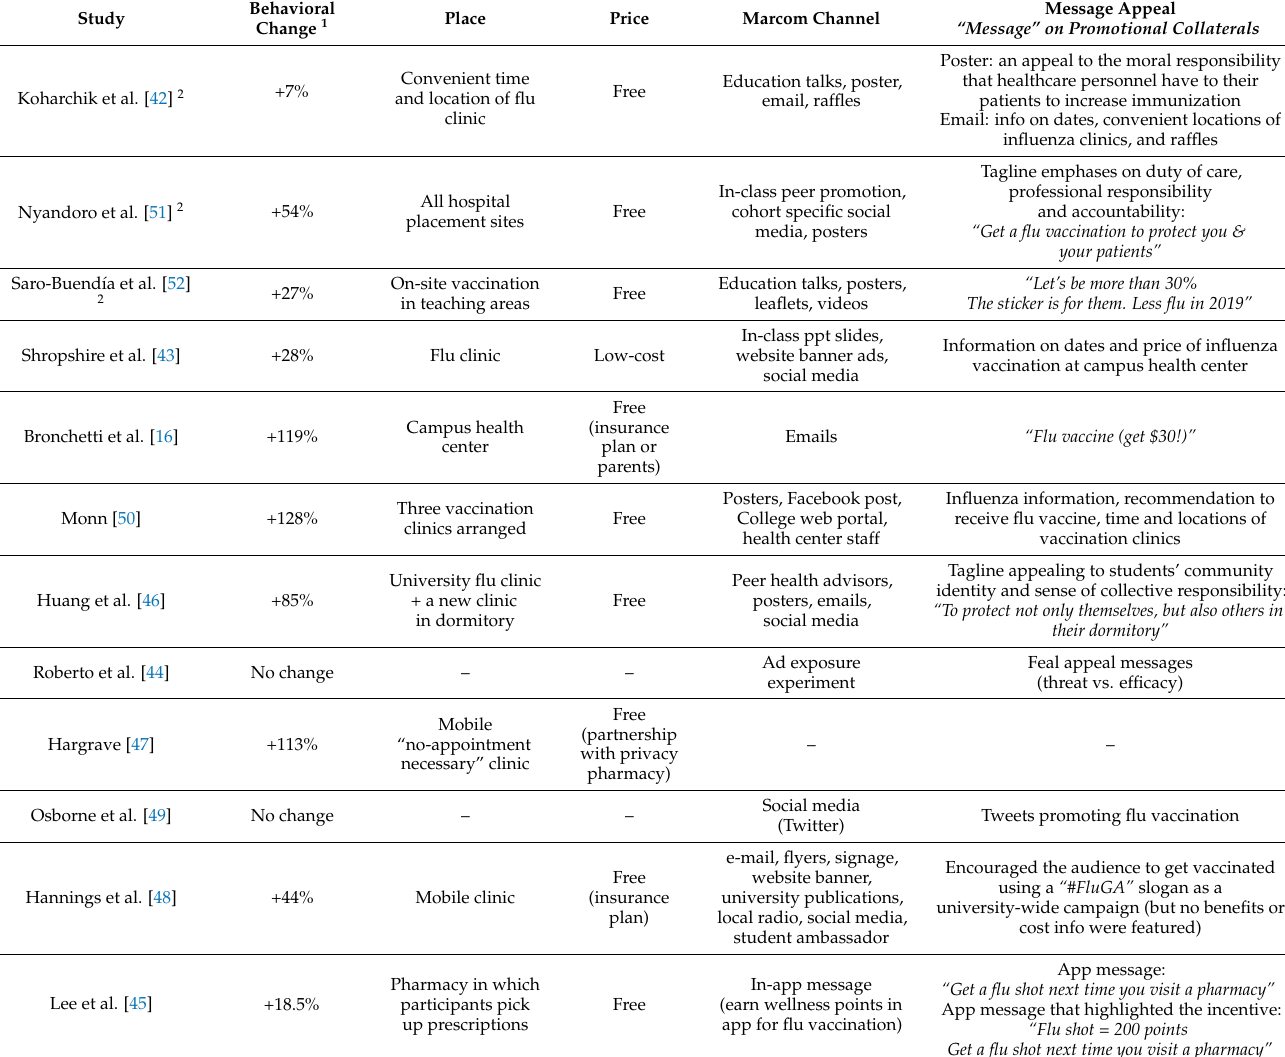
Table 4. Summary of marketing mix, marketing communication channel and message